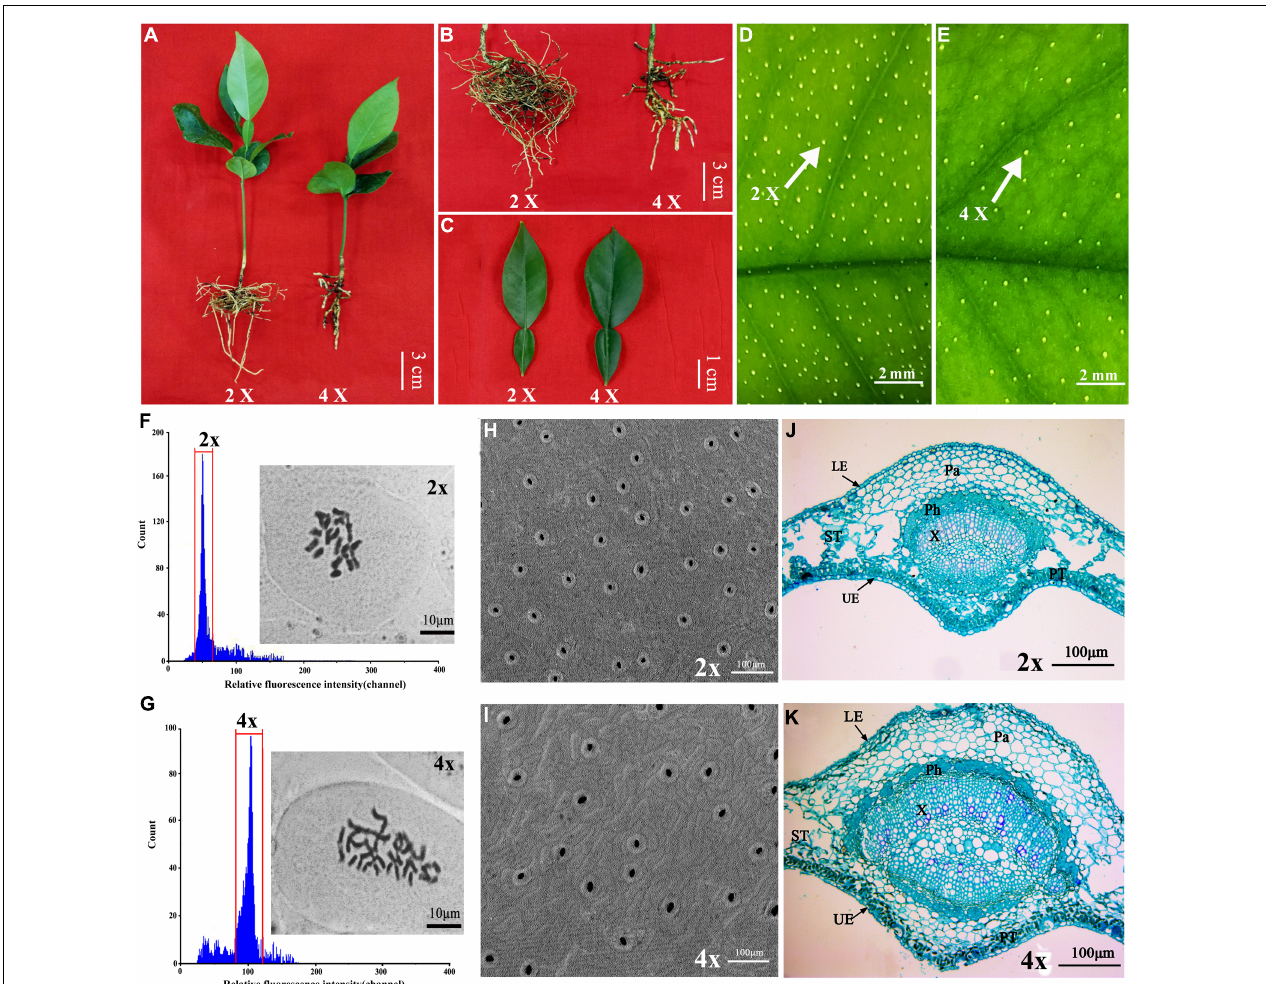
FIGURE 1 | Morphological and microscopic comparison between tetraploid and diploid in Citrus wilsonii . Plant height and morphology in 4-month-old diploid and tetraploids (A) ; roots morphology (B) ; leaf morphology (C) ; the density of oil glands cell in diploid (D) and tetraploid (E) leaves; ploidy level of diploid (F) and tetraploid (G) plants using FCM (flow cytometry) and chromosome counting analysis; scanning electronic microscopic observation of stomata in diploid (H) and tetraploid (I) leaves; microscopic observation using cross sections of diploid (J) and tetraploid (K) leaves. UE, upper epidermal; LE, lower epidermal; ST, spongy tissue; PT, palisade tissue; Ph, phloem; X, xylem; Pa, parenchyma tissue.